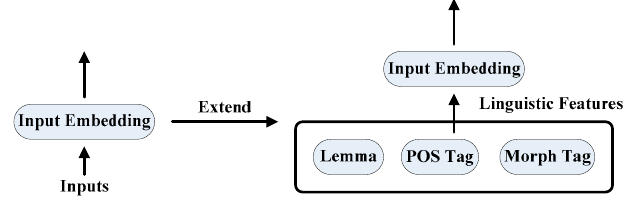
Figure 3. The input-embedding layer of the knowledge-based encoder. 179